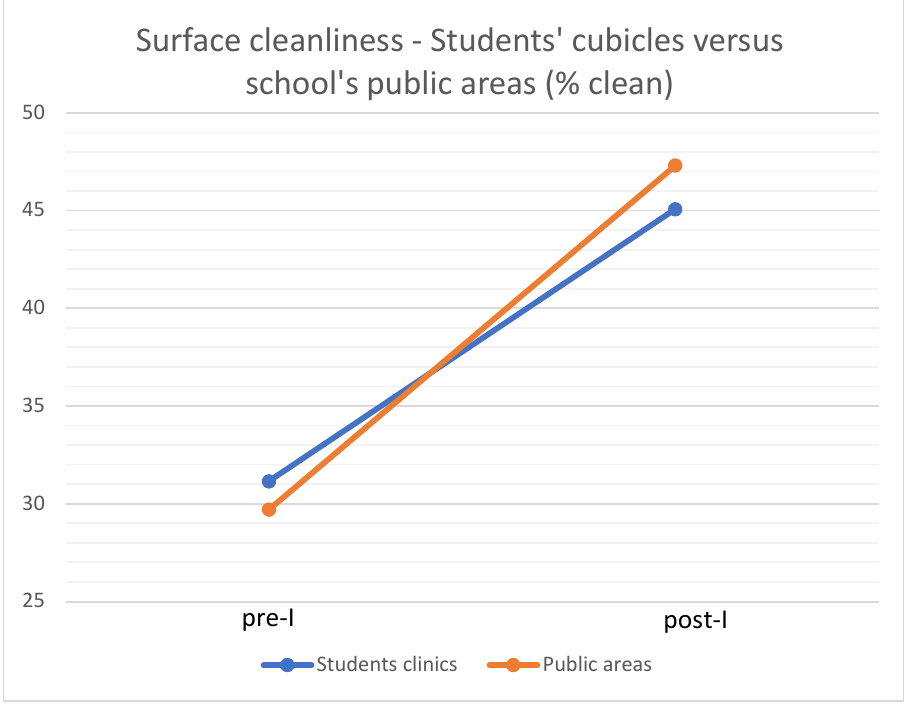
Figure 6. The mean values of surface cleanliness pre-I and post-I in students’ cubicles and in the school’s public areas.